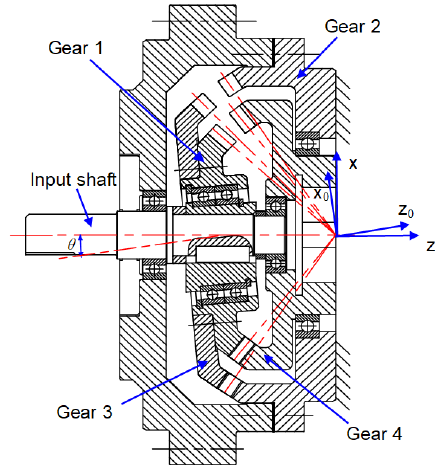
Figure 2. Cross-sectional diagram of the nutation reducer structure. Table 1. Main gear